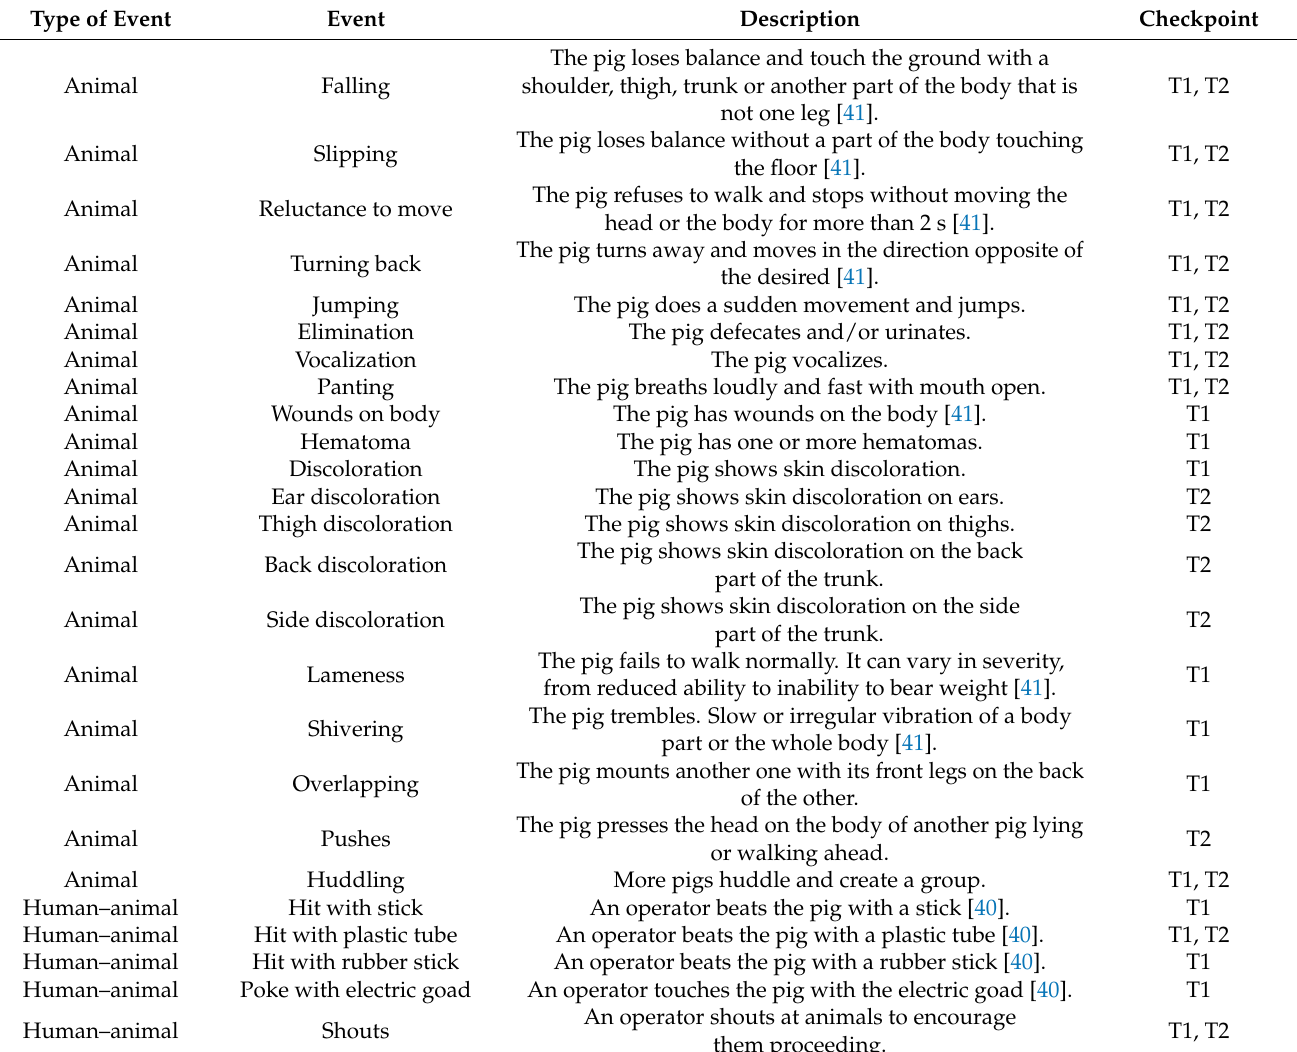
Table 1. Protocol used to annotate events, animal behaviors and skin discoloration of the pigs